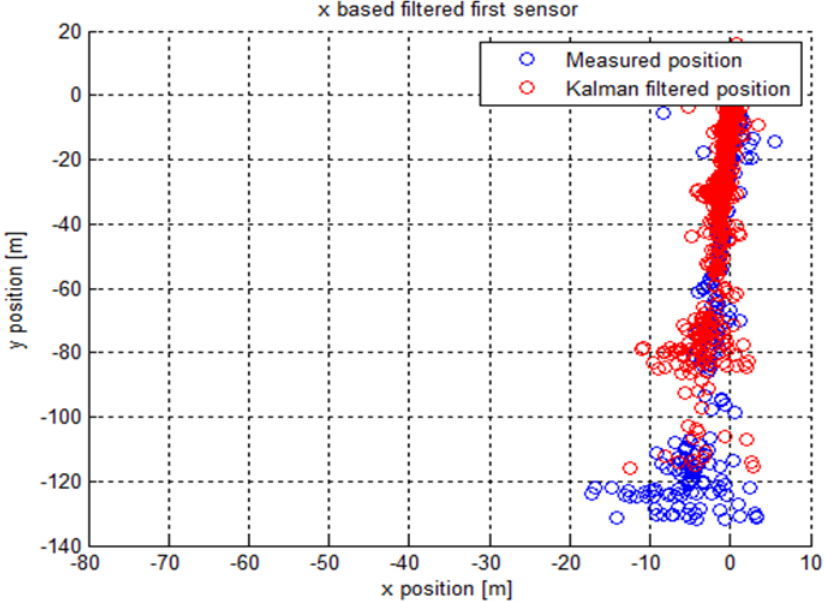
Figure 1. An example of a trajectory estimated by a tracker based on a Kalman filter.